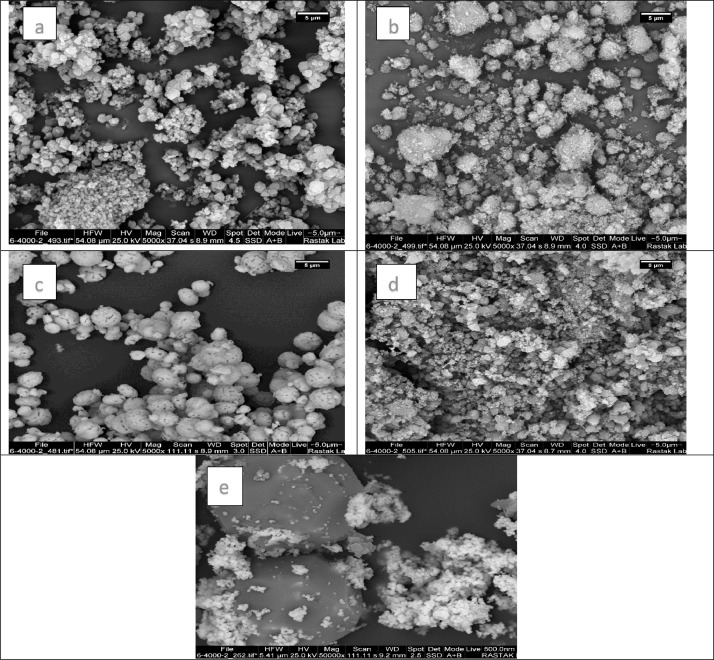
The FE-SEM images of the prepared nanomaterials of a) Zeolite, b) TiO2, c) BiVO4, d) TiO2/zeolite, e) BiVO4/zeolite.